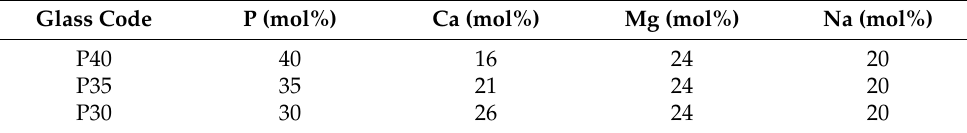
Table 4. Glass composition